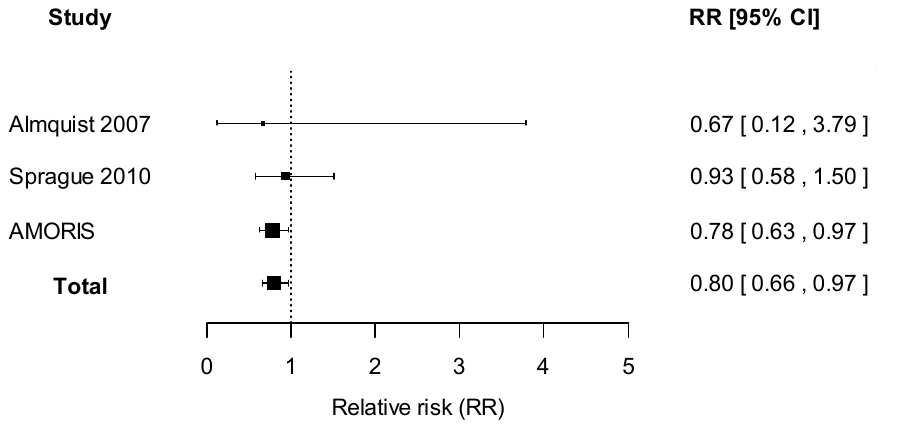
Figure 2. Forest plot for meta-analysis of the association between serum calcium and risk of breast cancer, expressed as relative risk of breast cancer for every 1 mmol/L increase in serum total calcium. Estimates from studies assessing serum calcium as categories were obtained from categorical regression.